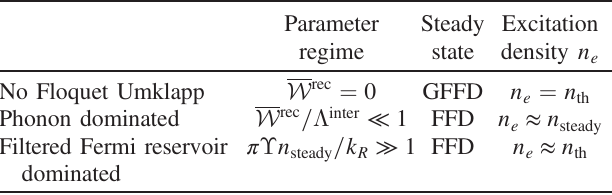
TABLE III. Summary of main results for the steady-state distributions in different regimes. FFD denotes a steady state in which electrons and holes in Floquet bands þ and − are described by separate Fermi-Dirac distributions with independent chemical potentials (at the bath temperature). GFFD stands for a global Floquet-Fermi-Dirac distribution, with a single chemical potential. Other symbols: n stands for the thermal excitation th density, while n is defined in Eq. (9). The parameter ϒ steady characterizing the tunneling rate to the Fermi reservoir is defined in Eq. (13), and W rec and Λ inter characterizing recombination and phonon-mediated interband relaxation rates are defined below Eq.